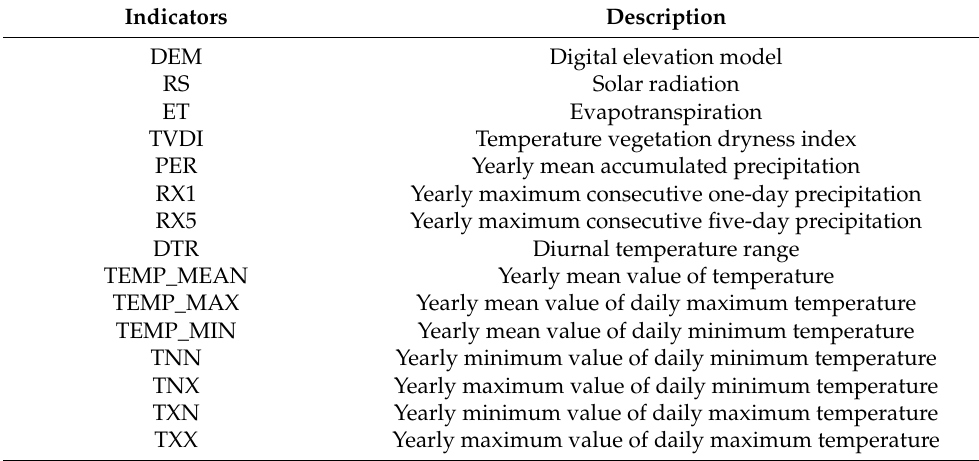
Table 1. The definitions and classifications of climate